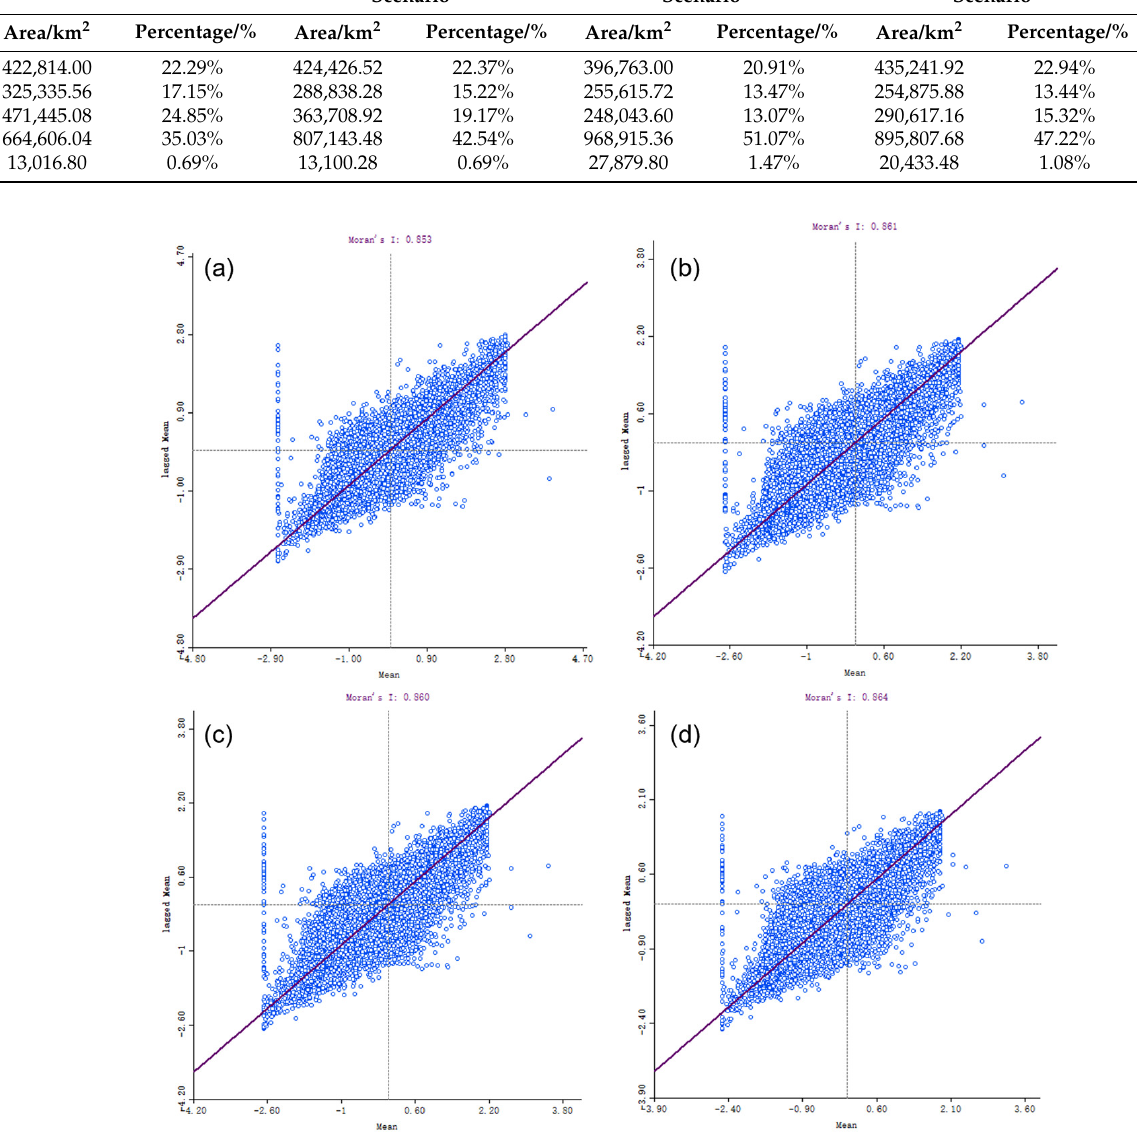
Figure 6. Moran Scatter Map of Landscape Ecological Risk in Xinjiang in 2020 and 2030 under Different Simulation Scenarios. ( a ) The scatter plot of Moran’s I for landscape ecological risk in Xinjiang in 2020. ( b – d ) are the Moran scatter plots for landscape ecological risk in Xinjiang under the simulated scenarios of natural development, urban development, and ecological conservation in 2030, respectively.